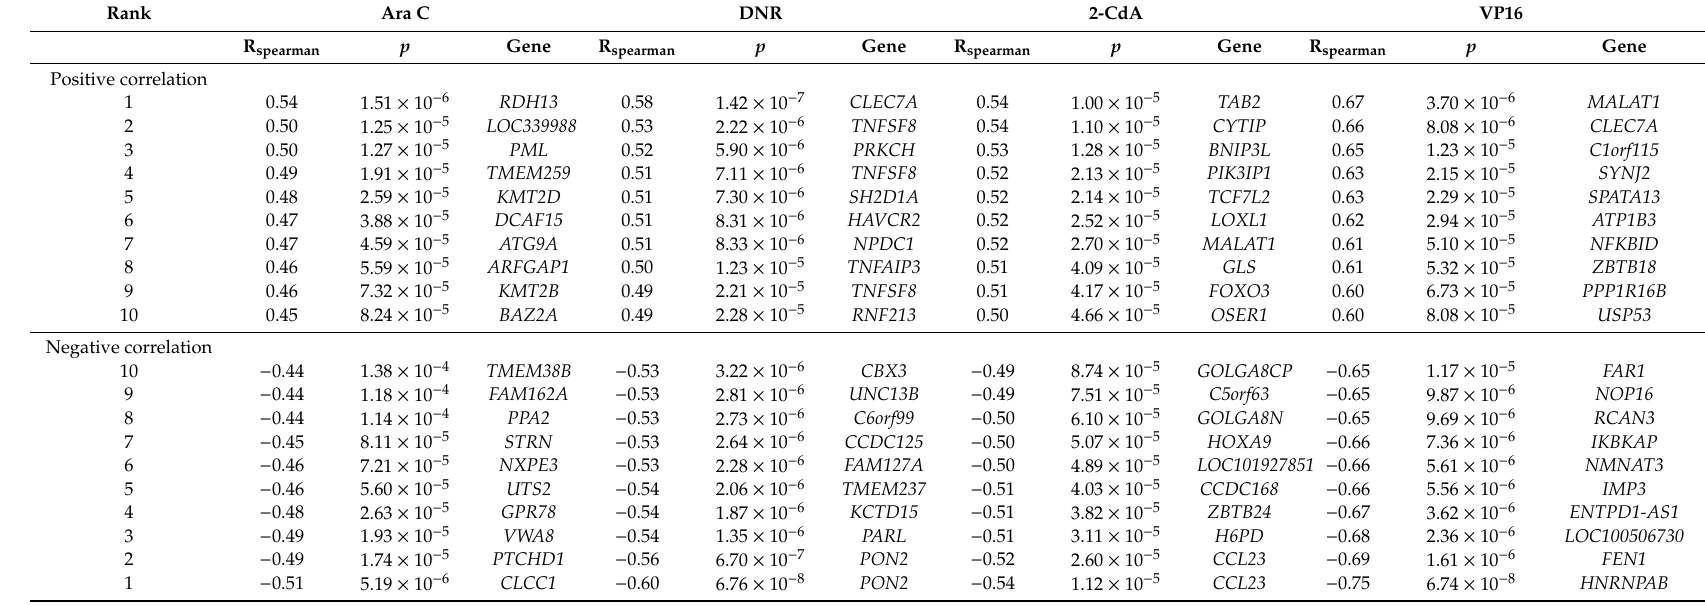
Table A3. Top 10 positively and negatively correlating genes per drug. Correlation coe ffi cient and p -values were calculated using the Spearman’s rank correlation. Rank Ara C Positive correlation 1